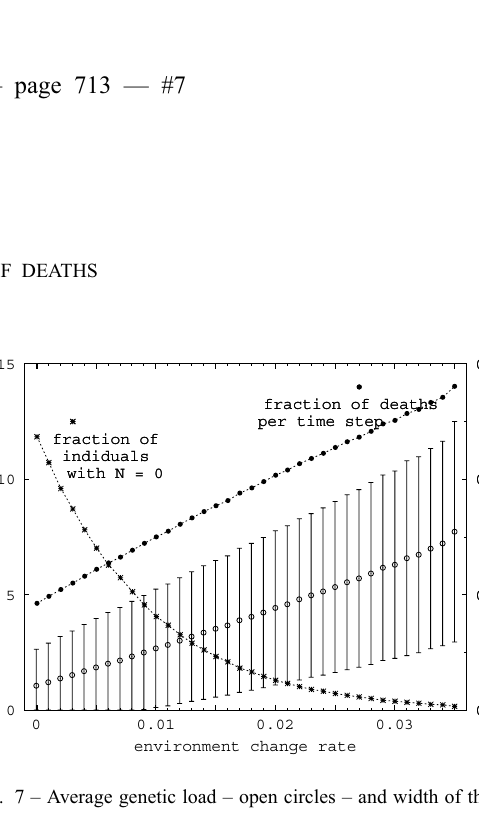
Fig. 7 – Average genetic load – open circles – and width of the dis- tribution of load – error bars – (y scale on the left), fraction of the population with no genetic load and fraction of deaths per time step (y scale on the right). Values correspond to averages taken after 5000 initialtimesteps,upto10 6 . Similarresultsareobtainedfor L ≤